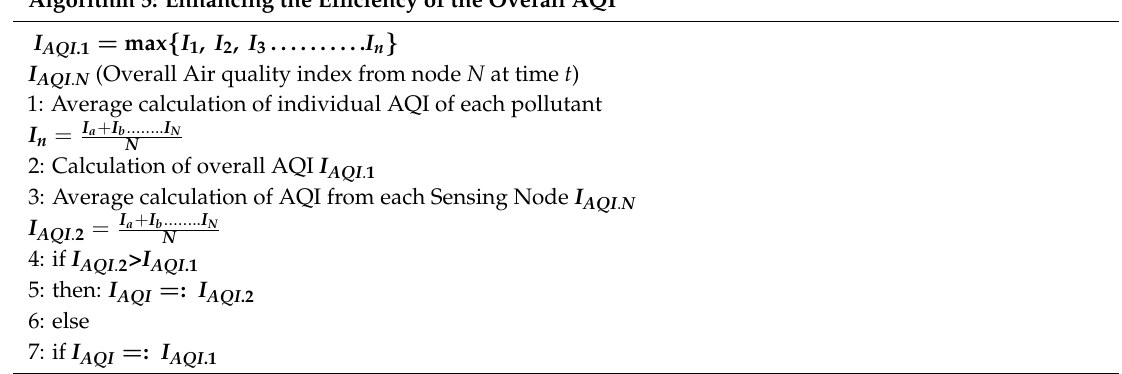
Algorithm 5: Enhancing the Efficiency of the Overall